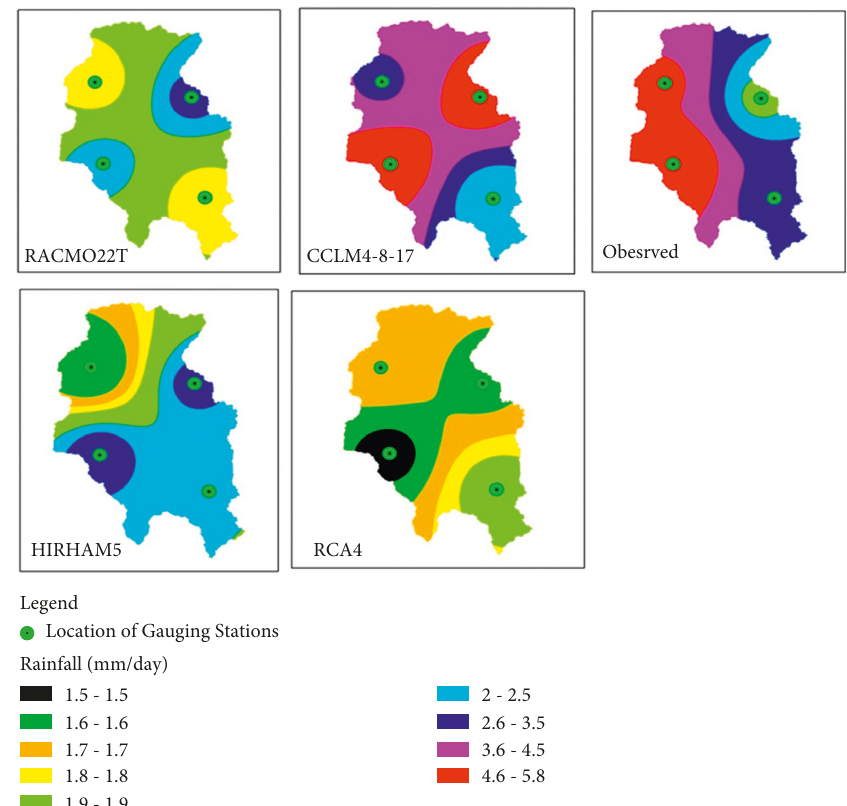
Figure 14: Spatial distribution of rainfall by four regional climate models at Akaki